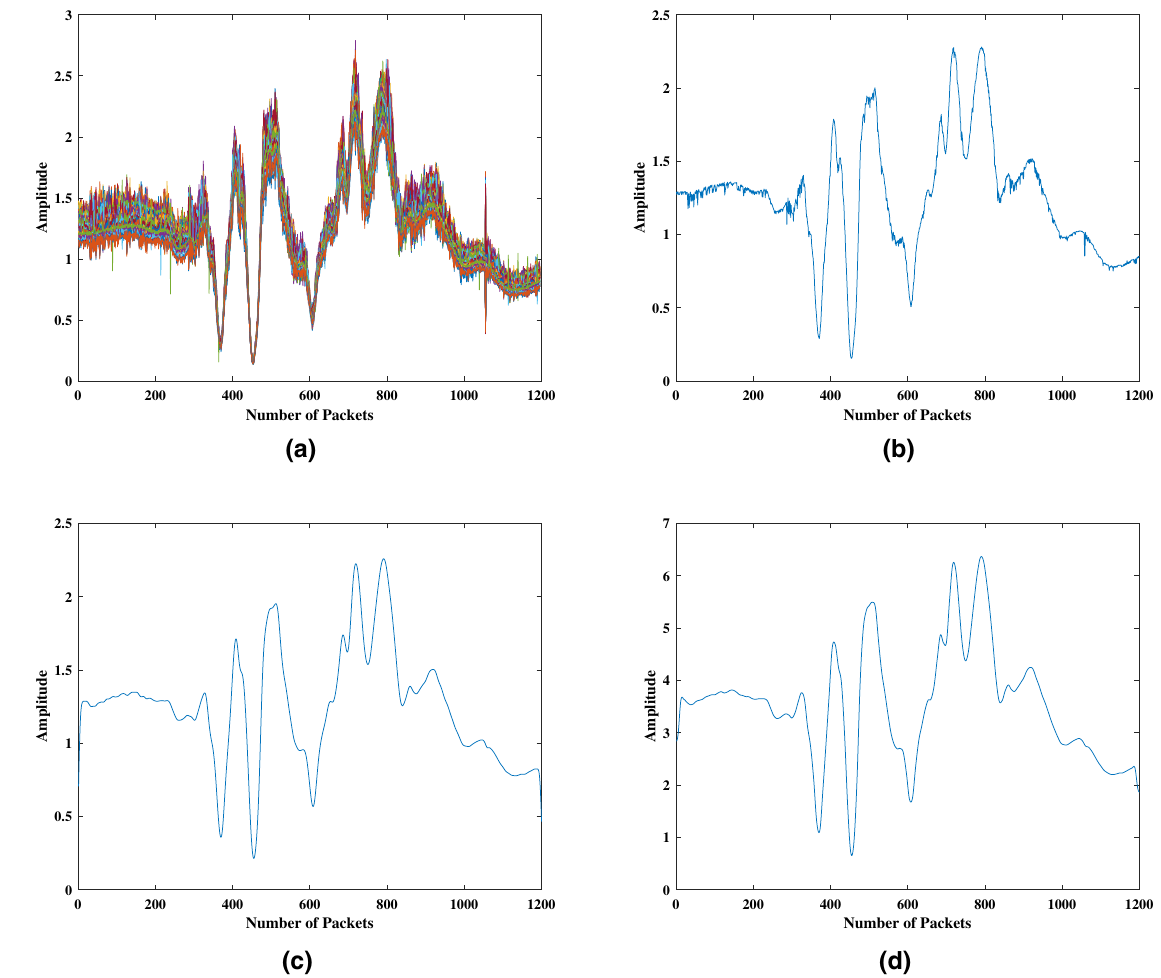
Figure 6. Data processing: ( a ) Raw data sample, ( b ) Averaged across all 51 sub-carriers, ( c ) Butterworth low pass filtering and ( d ) Approximation coefficients of a 3 level Discrete Wavelet